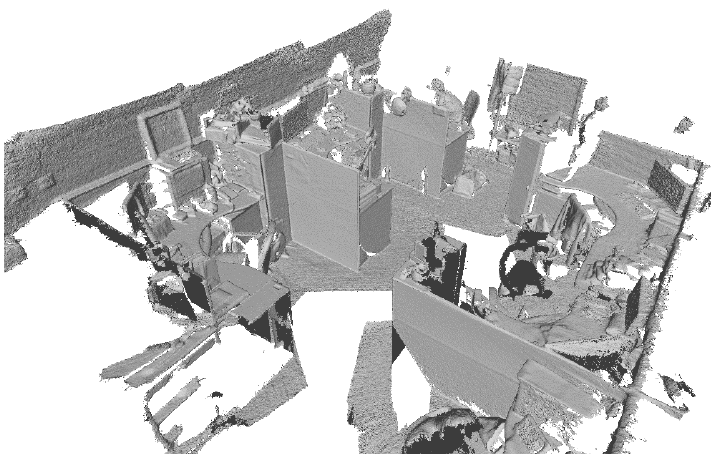
Figure 7. 3D reconstruction result by InfiniTAM. Sensors 2018 , 18 , x Table 2. Comparison between the actual lengths of seven line segments with the lengths measured in the reconstructed model